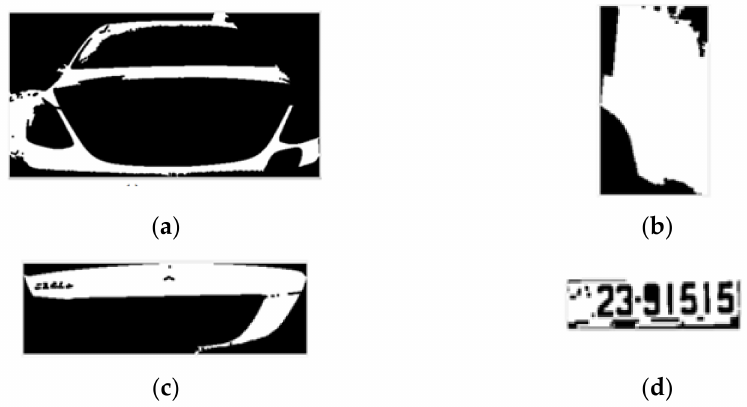
Figure 5. Examples of candidate regions, ( a – d ) are samples of candidate regions.